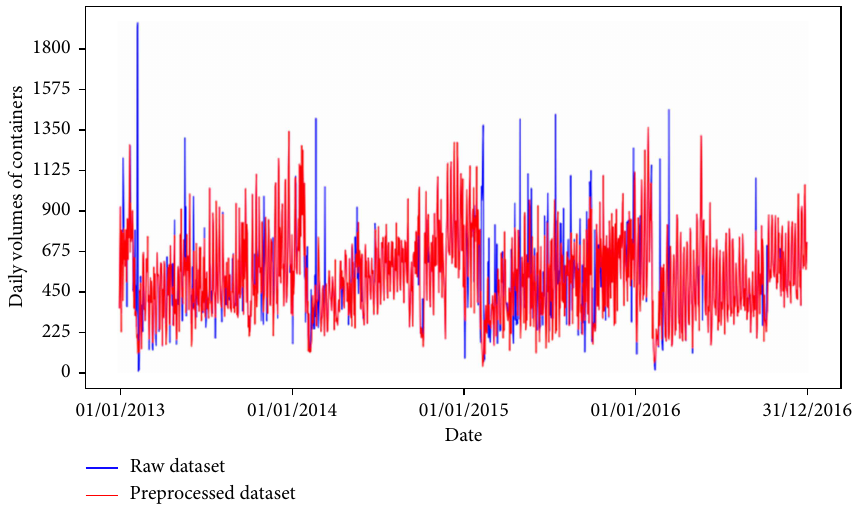
Figure 4: The preprocessed dataset of daily container volumes from 2013 to 2016.